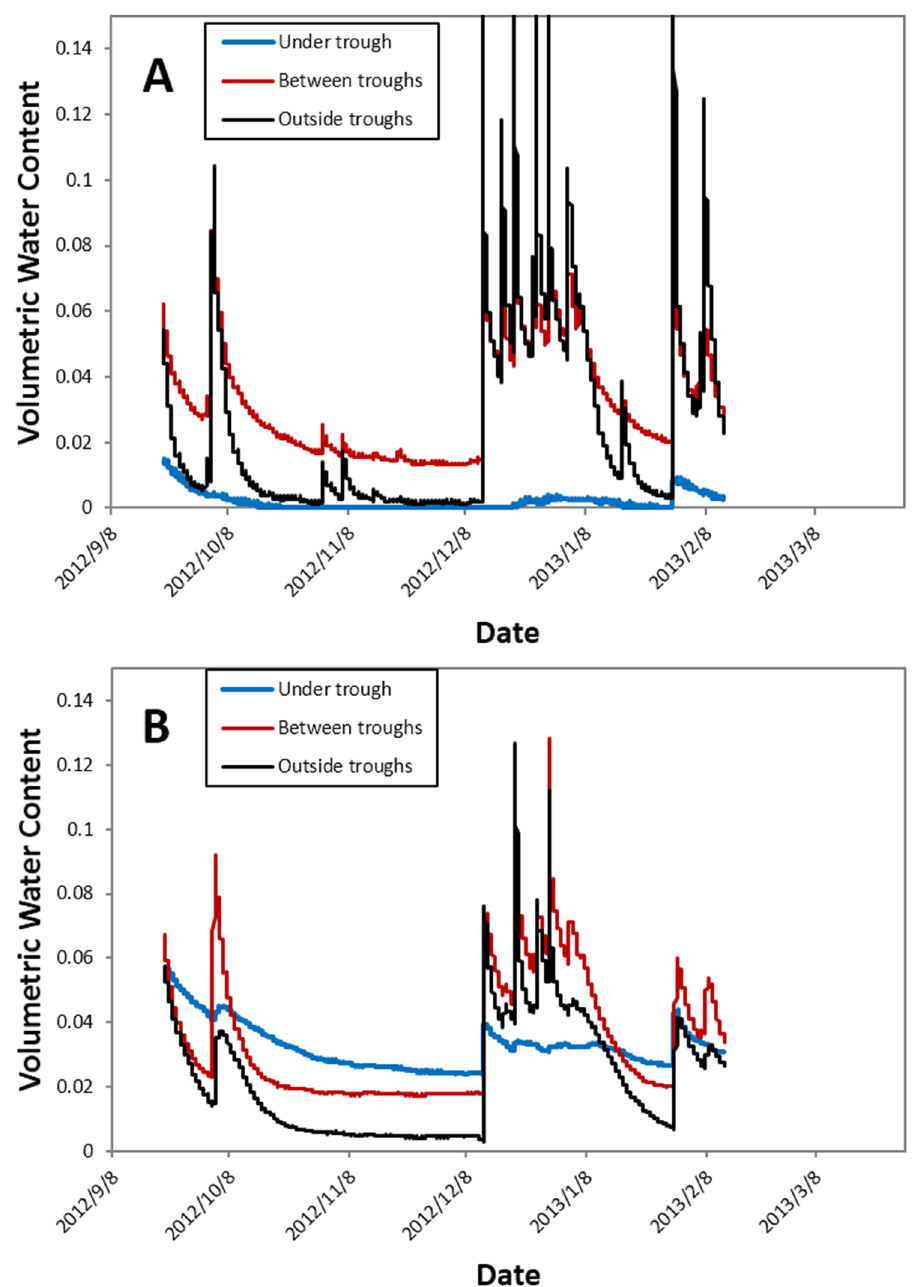
Figure 3. Temporal variation in volumetric water content at 0–12 cm ( A ) and 12–20 cm ( B ) depths at three locations relative to a throughfall diversion structure at the Taylor County, Florida